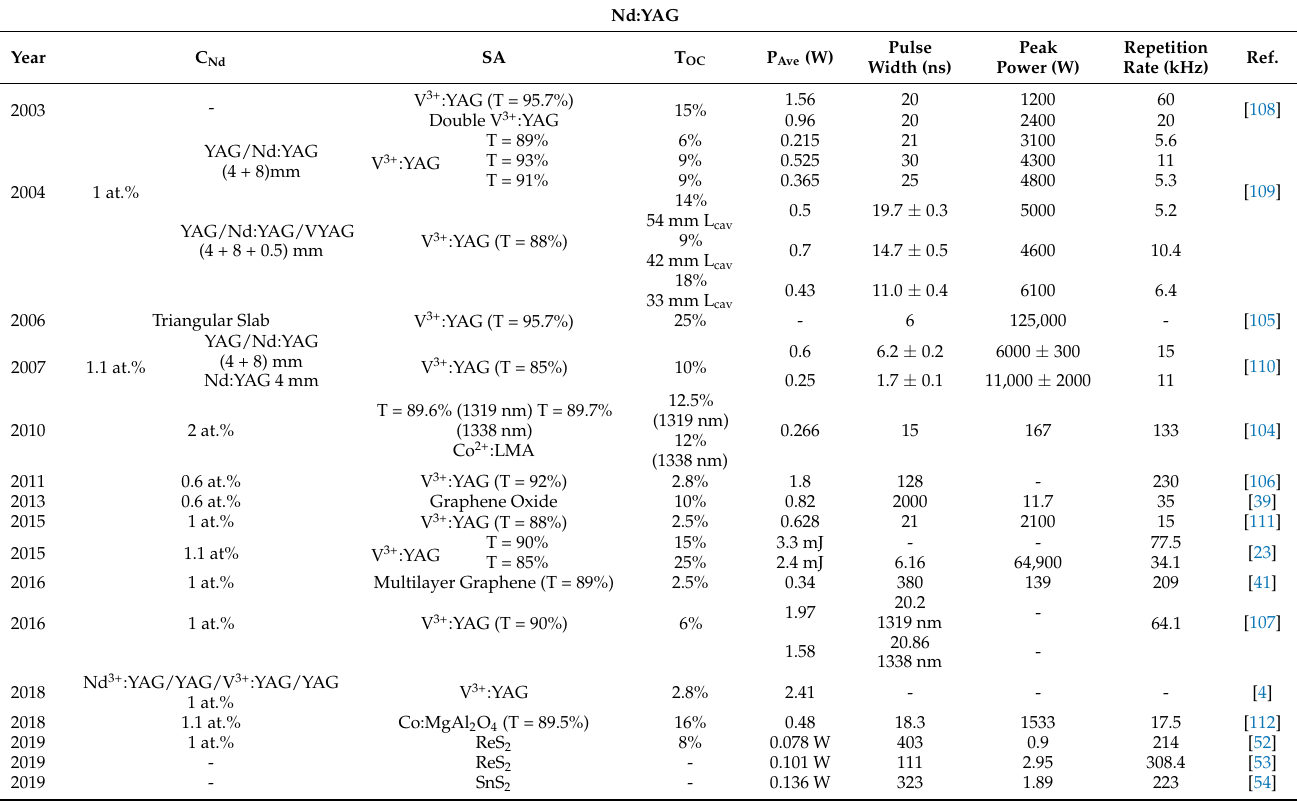
Table 3. Research progress on 1.3 µ m passively Q-switched Nd:YAG lasers.